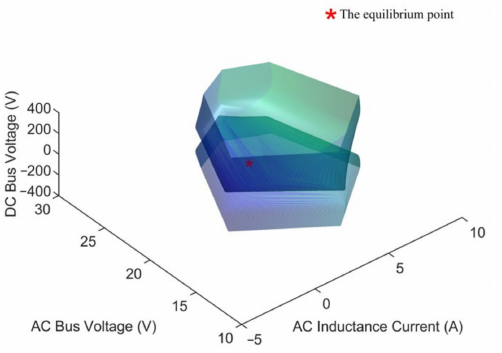
Figure 18. The 3D RAS of microgrids with the battery in charging mode (CPL power was 20 W).